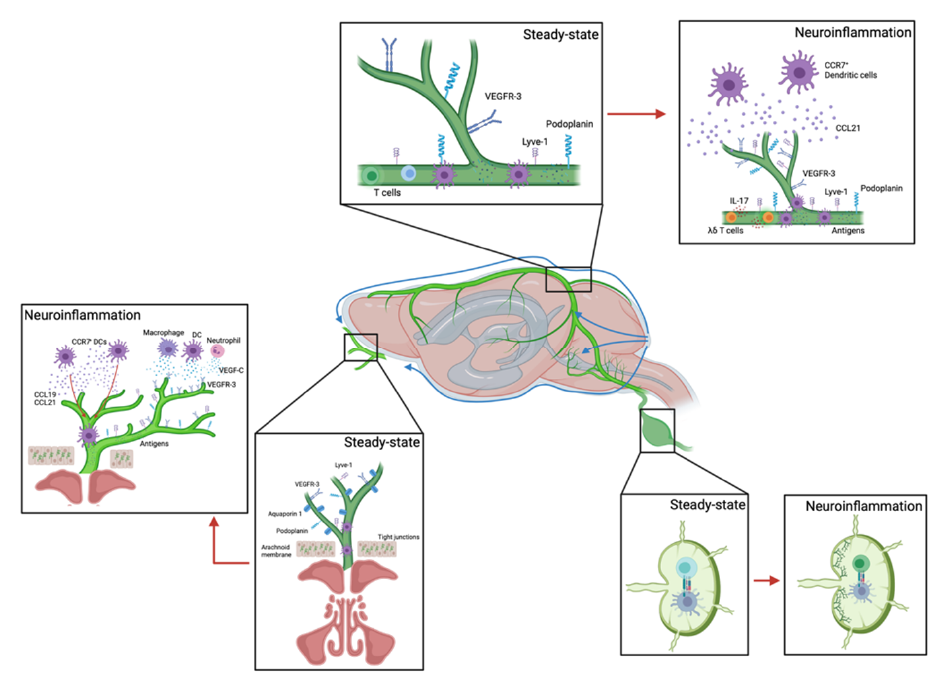
Figure 3. Schematic diagram of lymphangiogenesis occurring in the CNS after neuroinflammation (created with BioRender.com).